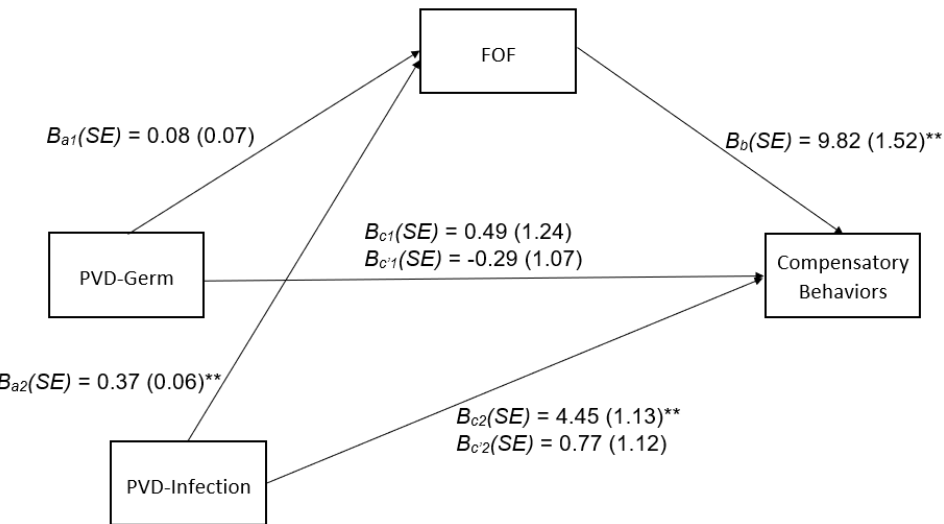
Figure A2. Sex — Stratified Analyses for PVD-Infection, FOF, and Compensatory Behaviors . Process Model — 4 path estimates from sex-stratified analyses testing the indirect effect of perceived germ aversion and perceived infectability on compensatory behaviors through fear of fat. Unstandardized coefficients and standard errors are presented (* p < 0.05, ** p < 0.01). Indirect effect of PVD-Germ path for male, B (SE) = − 0.15 (0.63), 95% CI [ − 1.53, 1.00] and female, B (SE) = 0.77 (0.68), 95% CI [ − 0.36, 2.35], participants. Indirect effect of PVD-Infection path for male, B (SE) = 2.84 (0.83), 95% CI [1.47, 4.73] and female, B (SE) = 3.68 (0.96), 95% CI [2.09, 5.88], participants.